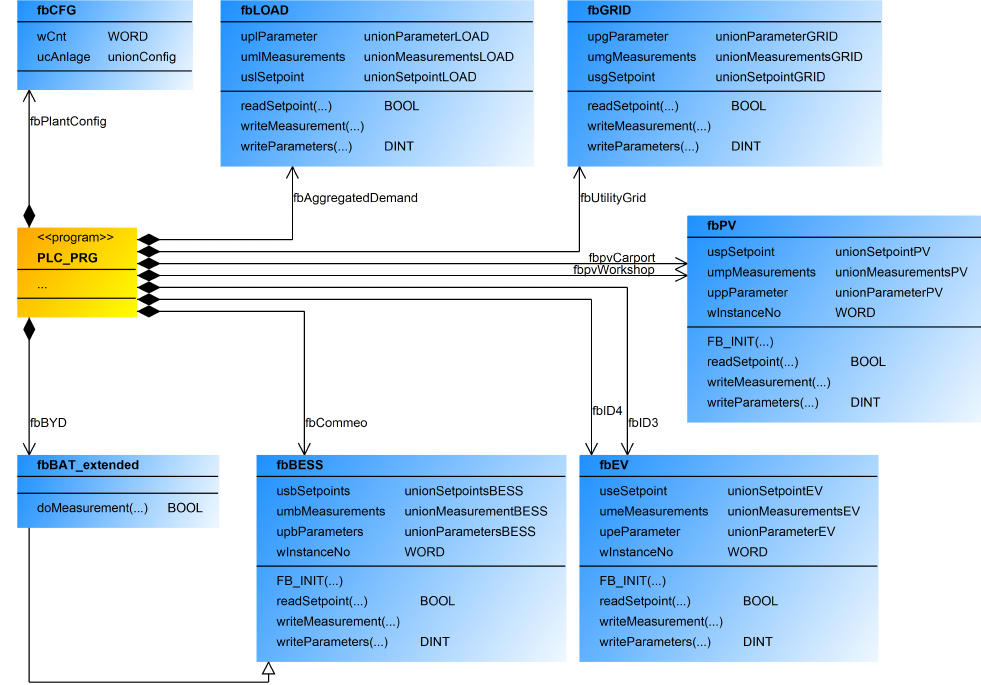
Figure 3. UML class diagram of the system configuration in the PLC. Exemplary system configuration (fbCFG) and parametrisation: one component each for the load (fbAggregatedDemand) and the utility grid (fbUtilityGrid), two PV Plants (fbpvCarport, fbpvWorkshop), two EVs (fbID4, fbID4), and two battery storages (fbBYD,